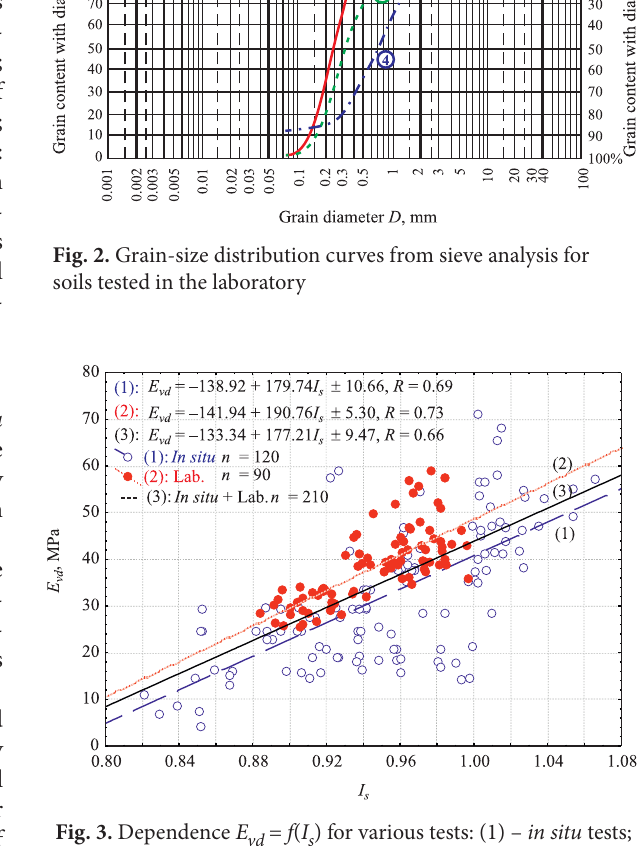
Fig. 3. Dependence E vd = f ( I s ) for various tests: (1) – in situ tests; (2) – laboratory tests; (3) – data from in situ tests and laboratory tests altogether